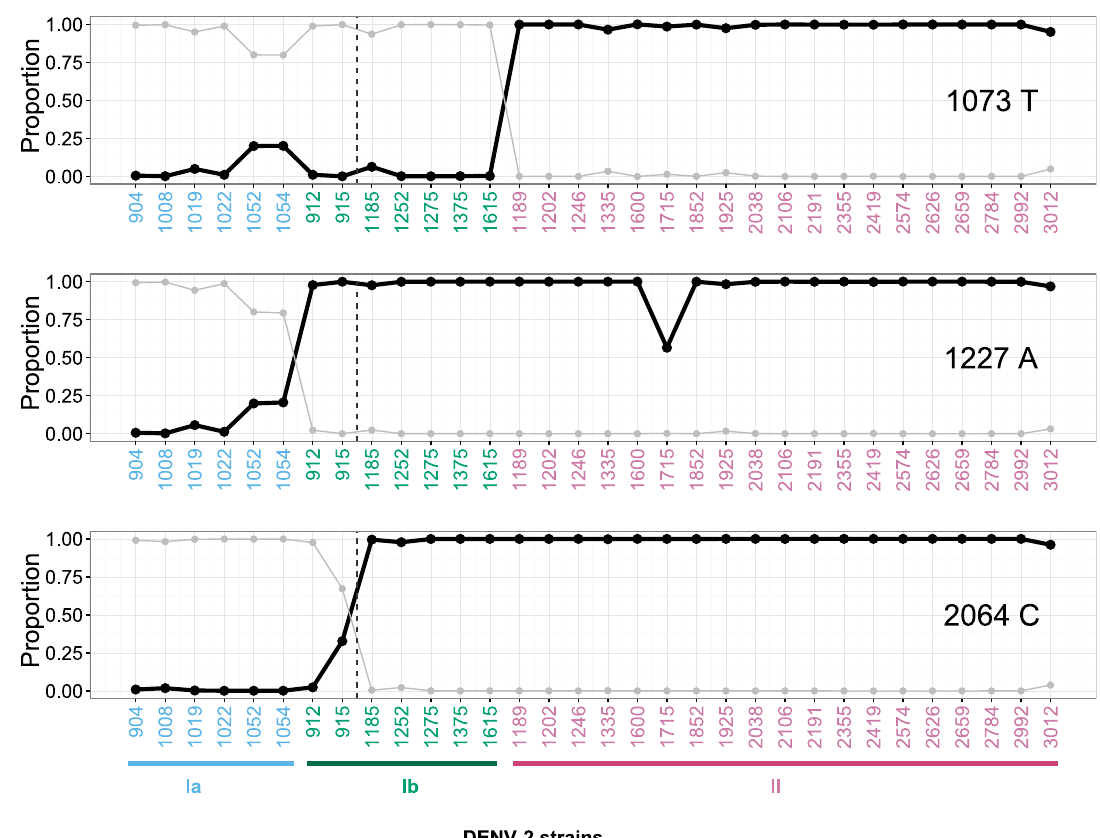
Fig 7. Deep sequencing of evolving viral populations. Proportions of quasi-species variants of each virus isolate (x-axis) are illustrated by three nucleotide positions in E-1073, -1227 and -2064. Proportions of Thymine (T) at position 1073 (upper), Adenine (A) at position 1227 (middle) and Cytosine (C) at position 2064 (lower) are shown separately in three panels, respectively, by black dots. Their corresponding putative nucleotide substitution counterparts - 1073C, 1227T, and 2064T are shown in gray dots. Three phylogenetic groups of DENV-2 variants are highlighted by different colors (Ia-blue, Ib-green, and II-purple) on the x-axis. Viruses are arranged by the chronological order of their isolation dates within each group. The vertical dashed line separates viruses isolated in 2001 (left side) versus those in 2002 (right